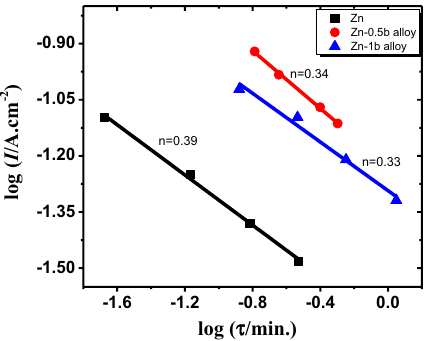
Figure 6. Logarithmic relationship between the duration of the anodic arrest and the density of current for the pristine zinc and its alloys I and II in 6 M KOH at 25